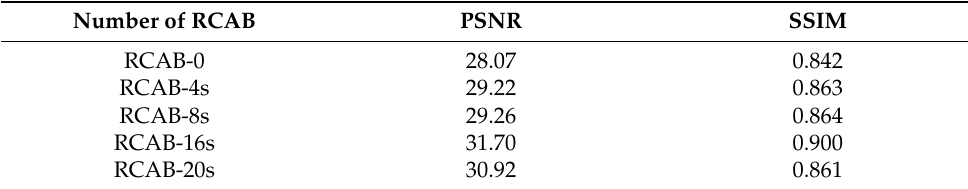
Table 6. The importance of RCAB for the inverse halftoning.